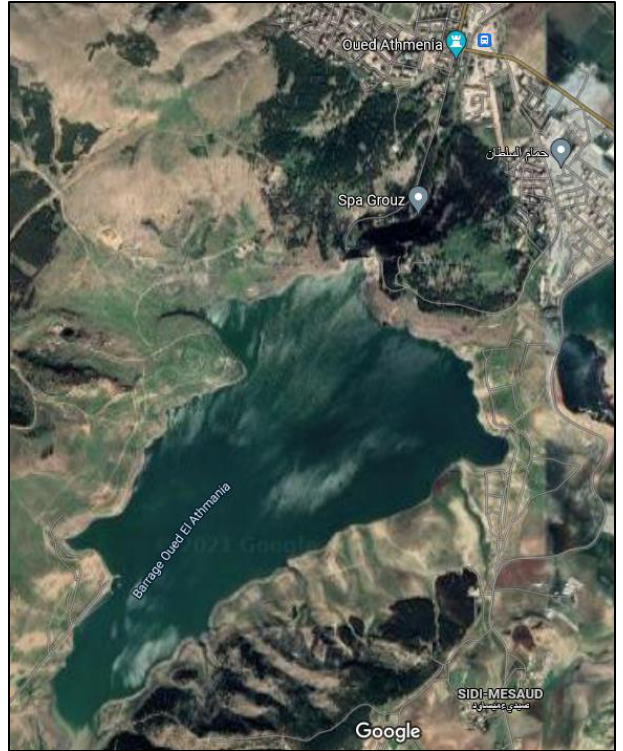
Figure 4. Satellite photo of Hammam Grouz